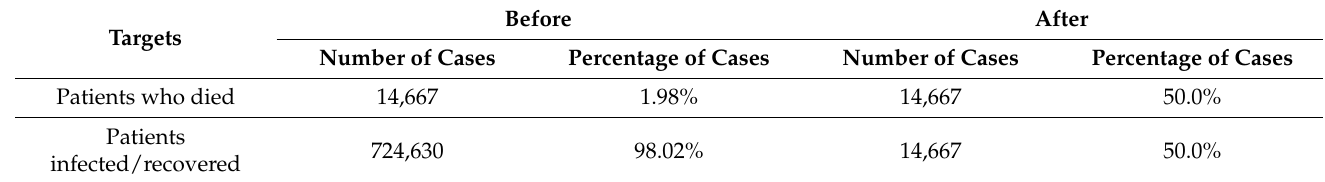
Table 6. Distribution of cases using